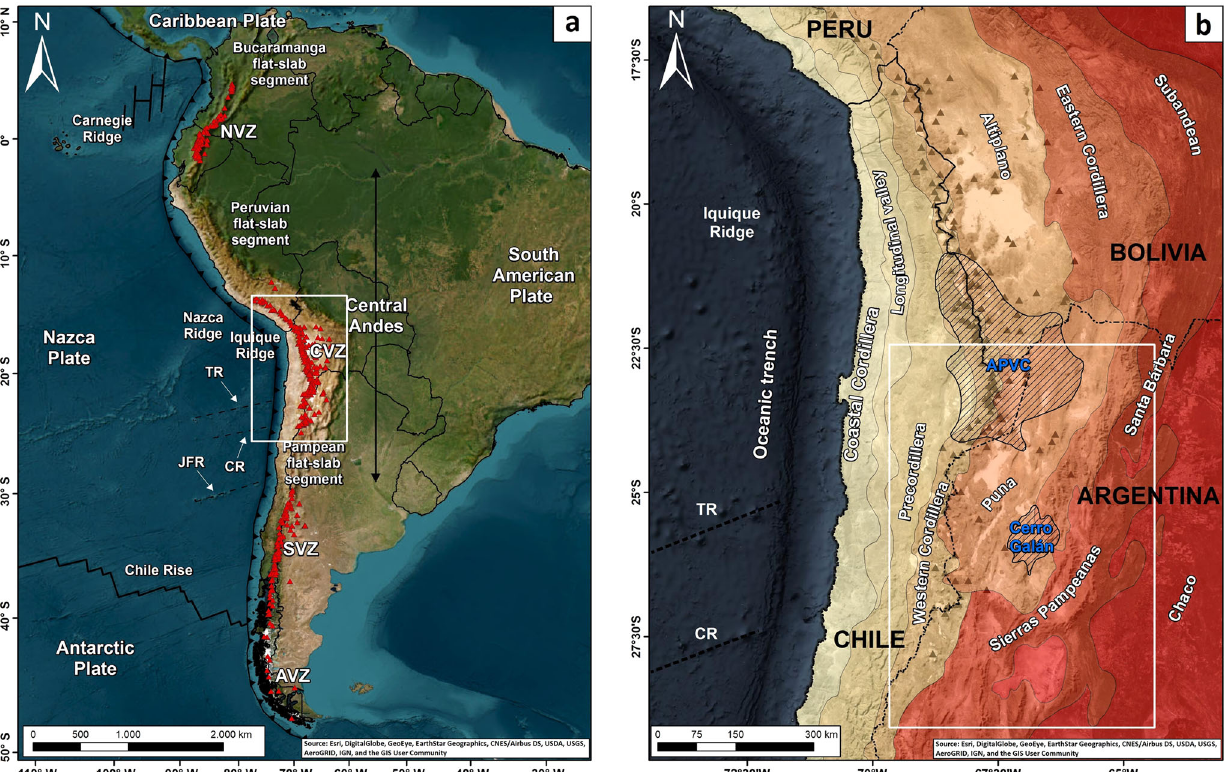
Fig. 1 Location map of the Central Andes. a Main tectonic elements. JFR Juan Fernández, TR Taltal, CR Copiapó ridges, based on Bello-González et al. 51 . NVZ Northern Volcanic Zone, CVZ Central Volcanic Zone, SVZ Southern Volcanic Zone, AVZ Austral Volcanic Zone, based on Stern et al. 73 . b Main tectonomorphic regions. White rectangle in ( b ) indicates our study area. Red triangles in ( a ) and gray triangles in ( b ) correspond to the Neogene- Quaternary volcanoes according to Siebert et al. 74 . The black striped regions in ( b ) depict the Altiplano-Puna Volcanic Complex (APVC 63 ) and the Cerro Galán 56 ignimbrite